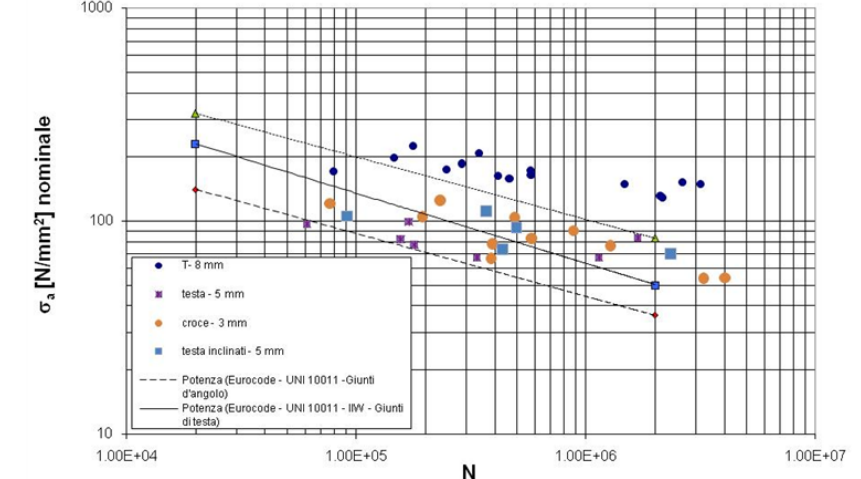
Figura 3: Curve di resistenza a fatica in termini di ampiezza di tensione per